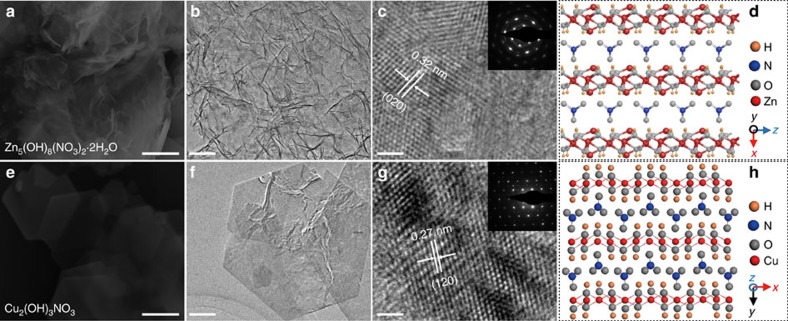
Characterization of anion intercalated 2D hydroxides.Characterization of Zn5(OH)8(NO3)2·2H2O. (a) SEM image; (b) low-resolution TEM image; (c) high-resolution TEM image; (d) atomic structure. Characterization of Cu2(OH)3NO3. (e) SEM image; (f) low-resolution TEM image; (g) high-resolution TEM image; (h) atomic structure. Scale bar for a,e is 1 μm, b,f is 200 nm and c,g is 2 nm.